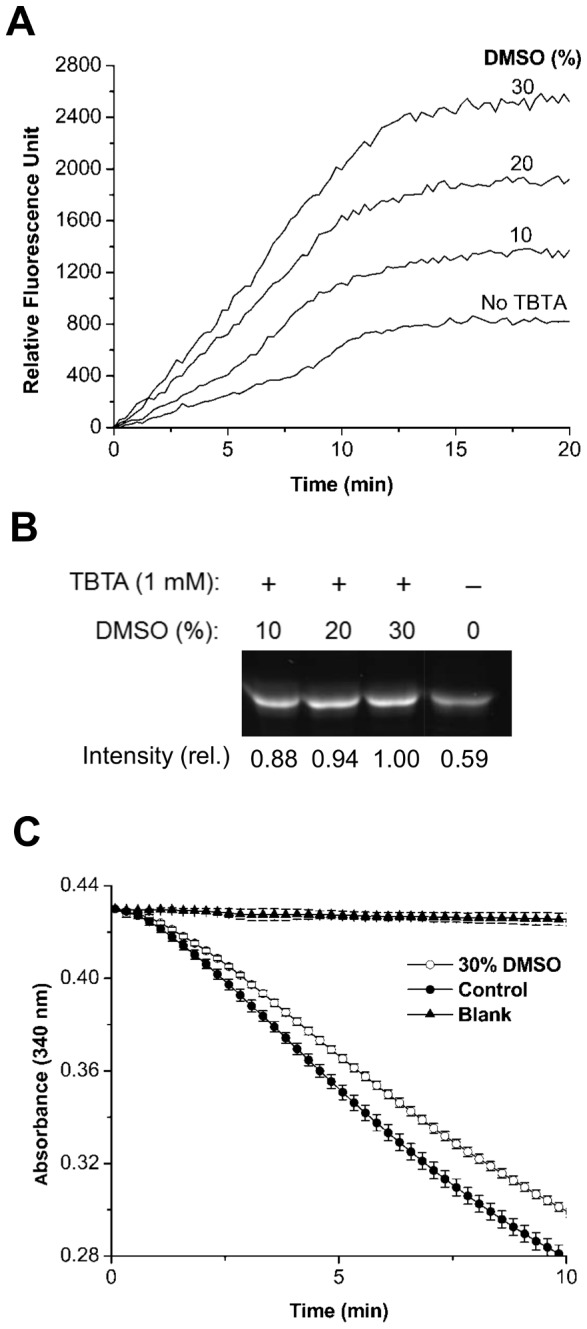
Performance of TBTA-assisted CuAAC reactions under various DMSO concentrations and their effects on the enzymatic activity.(A) Kinetic traces detected at various DMSO volume concentrations in the presence of TBTA or in a DMSO-free buffer without TBTA. Reactions were initiated at 25°C by adding ascorbate (2 mM) to a phosphate-buffered (pH 8.0) mixture containing 30 µM of the mDHFR-43pEthF, 60 µM of azidocoumarin, 1 mM of CuSO4, 1 mM TBTA, and appropriate DMSO contents. Fluorescence evolution was recorded at λex = 400 nm and λem = 470 nm. (B) In-gel fluorescence of an equal amount of reaction products. Relative intensities were quantified by densitometry. (C) Effect of DMSO incubation on activity of the mDHFR-43pEthF. After incubation of 30 µM protein in 10 µl of DMSO-free (closed circle) or 30% (v/v) DMSO-containing phosphate buffer (pH 8.0) (open circle) for 15 min at 25°C, the mixture was diluted 36-fold with the assay buffer for activity assay as described in Materials and Methods. Relative activity was calculated based on changes in absorbance for 10 min after initiation of the enzymatic reaction. Error bars represent standard errors (n = 3).